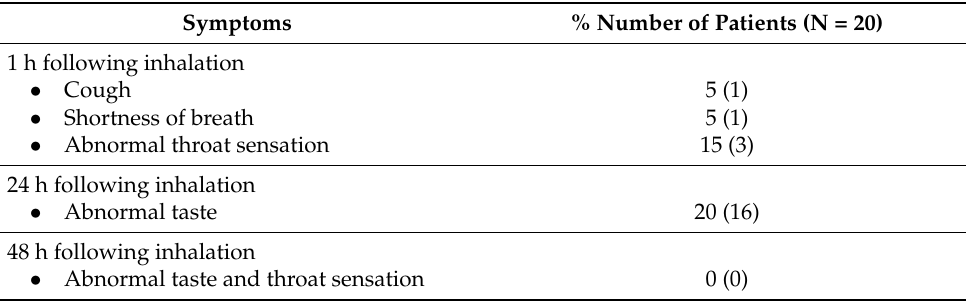
Table 3. Adverse effects following pulmonary dosing with nebulized TAC-LAC colloidal dispersion (3 mg